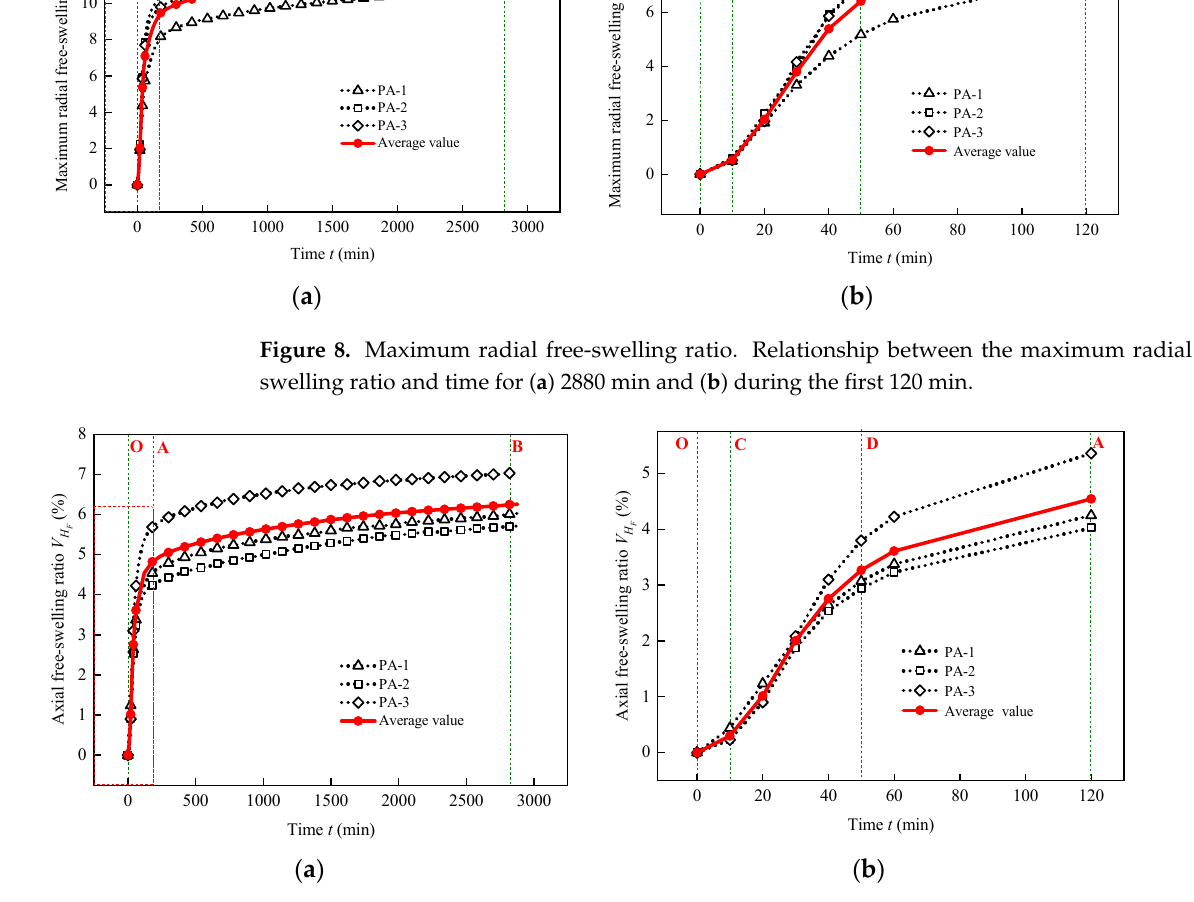
Figure 9. Axial free ‐ swelling ratio. Variation in axial free ‐ swelling ratio for ( a ) 2880 min and ( b ) during the first 120 min.